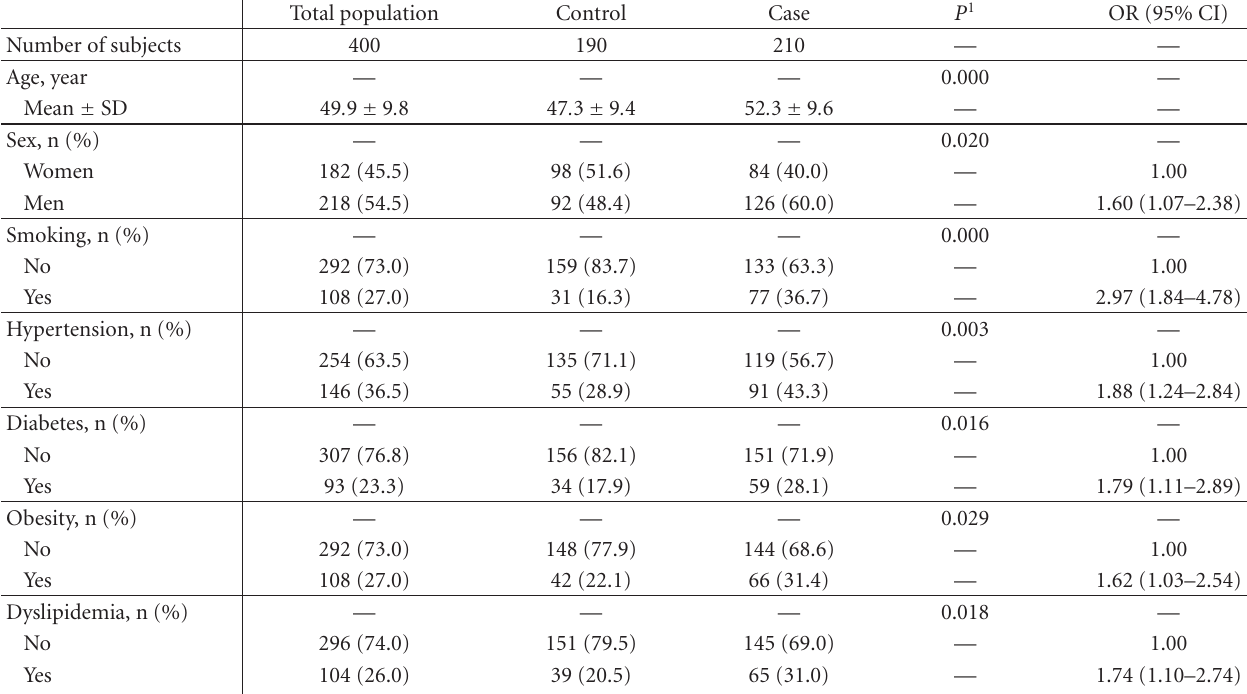
Table 1: Characteristics of the studied population and OR of CAD associated to traditional risk factors. P 1 is a comparison between case and control groups of mean age (ANOVA) , and traditional risk factors (chi-square test) . OR: odds ratio; 95% CI: 95% confidence